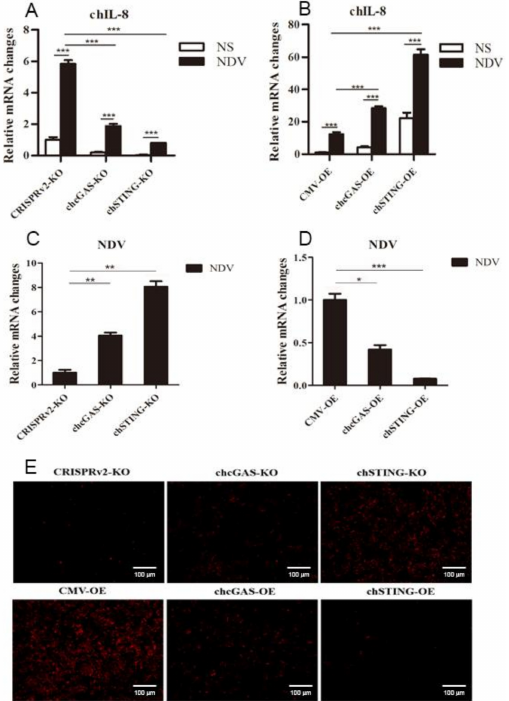
Figure 10. NDV-RFP replications in chGAS and chSTING stable HD11 cells. HD11 KO and OE stable cells in 12-well plate (2 × 10 5 cells / well) were infected with NDV-RFP (0.01 MOI) for 8 h and 14 h, respectively. The cells were analyzed by RT-qPCR for both cellular gene transcriptions ( A,B ) and viral gene transcriptions ( C,D ). The viral replications in HD KO and OE cells were also monitored by RFP fluorescence microscopy ( E ). The signs “*”, “**”, “***” p < 0.05, p < 0.01 and p < 0.001,